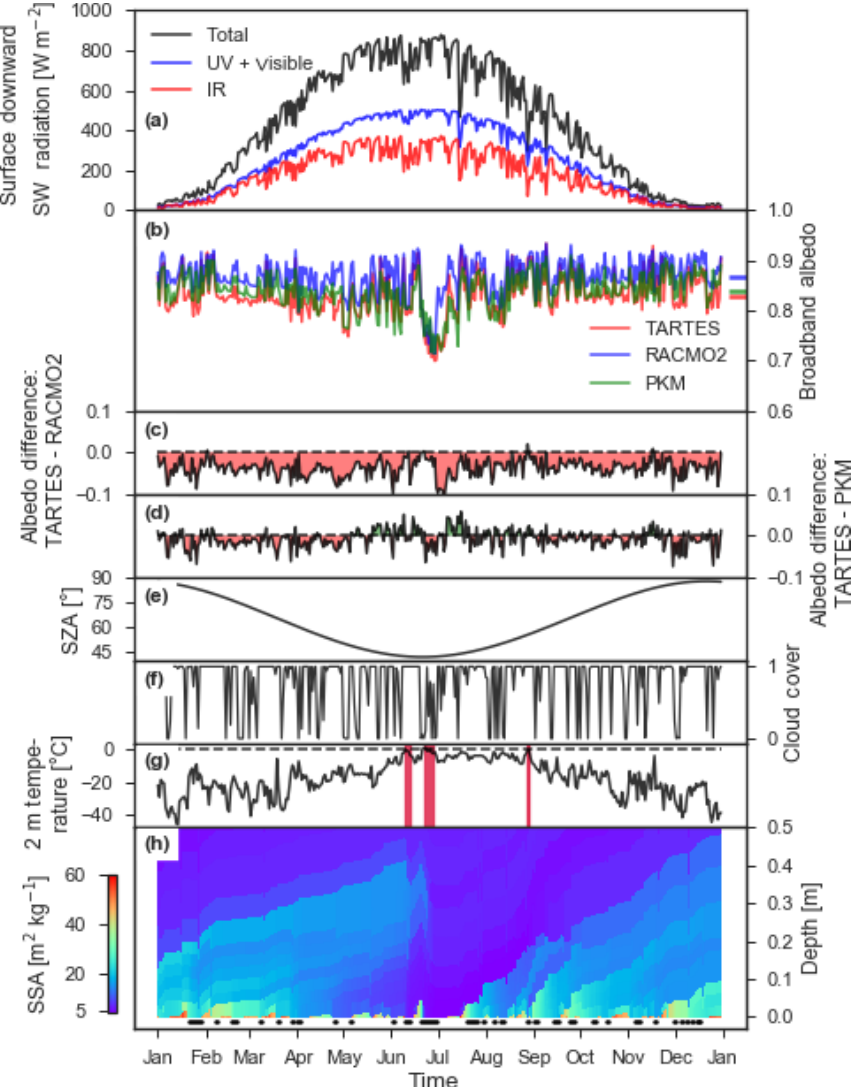
Figure 12. Time series for 2007, 15:00UTC (12:00LT) at the location indicated by the plus sign in Fig. 10. (a) The surface downward shortwave radiation, with the total flux split into an IR and UV plus visible radiation part; (b) broadband albedo computed by TARTES weighted with DISORT, RACMO2 and PKM; the mean albedo is indicated by the horizontal bars; (c) the albedo difference of TARTES – RACMO2 and (d) TARTES – PKM, with red indicating a negative and green a positive difference; (e) solar zenith angle; (f) cloud cover; (g) 2m temperature, with red bars indicating melt days; (h) specific surface area of the snow layers as a function of depth, with the horizontal black bars at the bottom indicating moments without a top fresh snow